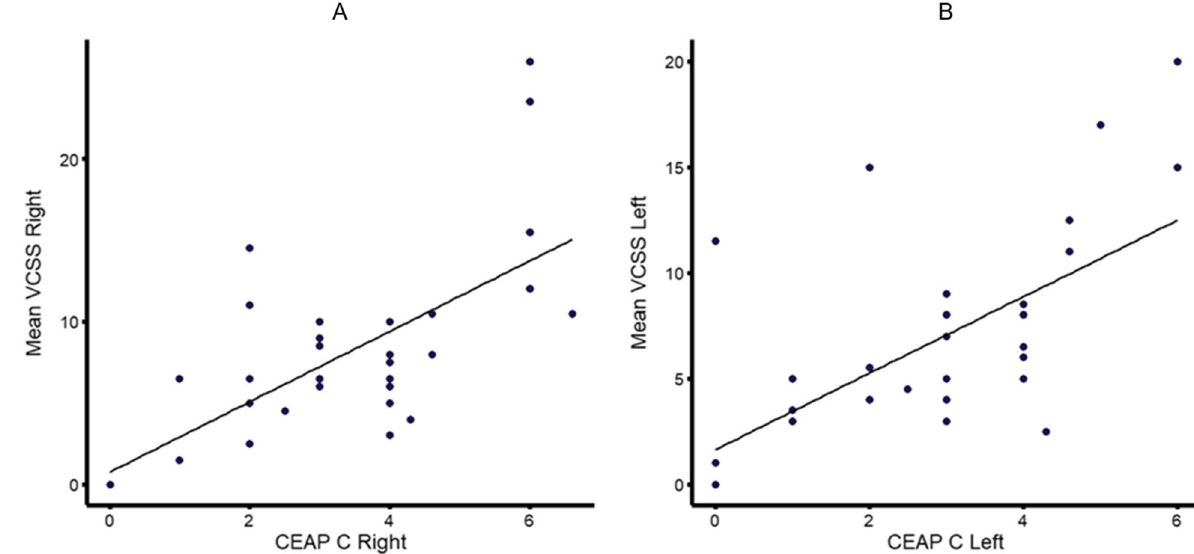
Fig. 3 Correlation of VCSS score and CEAP C class A right leg, B left